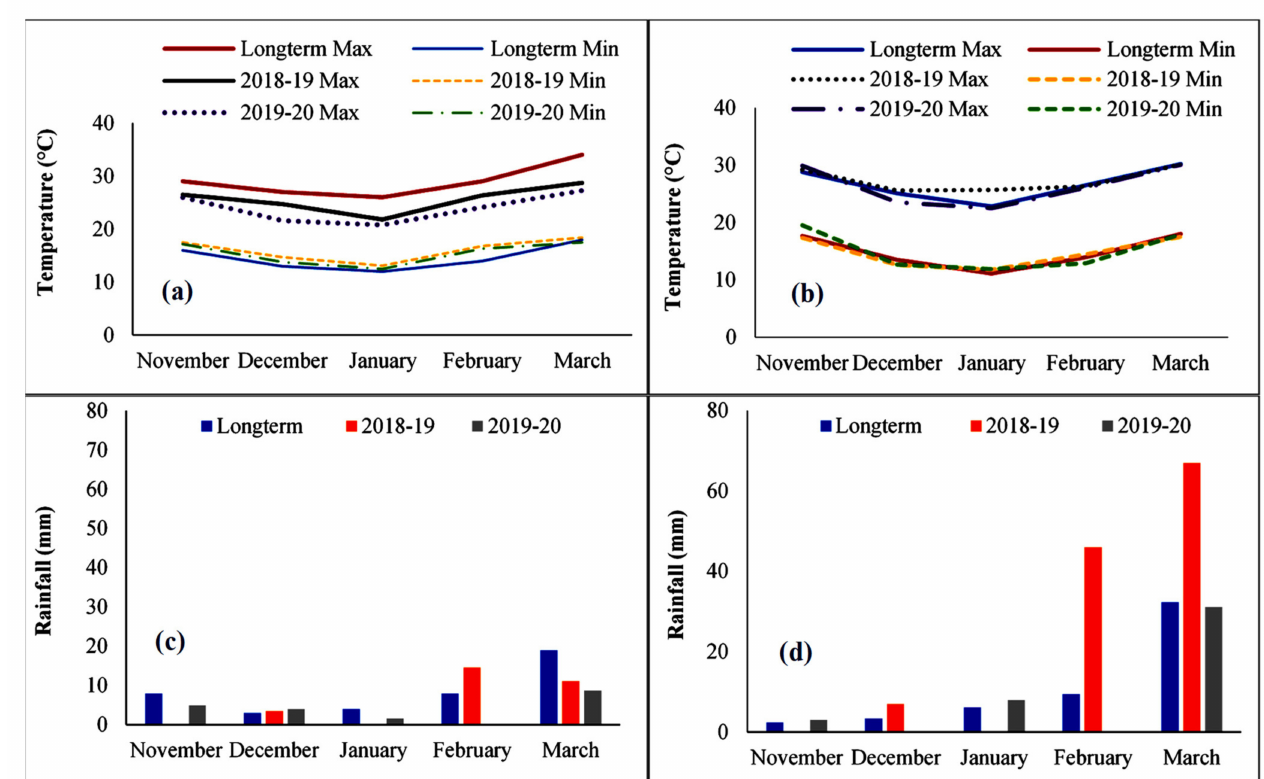
Figure 1. Monthly average maximum and minimum temperature of ( a ) Saghata, Gaibandha, and ( b ) Pirganj, Rangpur; ( c ) monthly mean rainfall (mm) of Saghata, Gaibandha, and ( d ) monthly mean rainfall (mm) of Pirganj, Rangpur, during two years compared to long-term (2000–2019) standards at Bangladesh Meteorological Department. Table 1. Initial soil condition (0–15 cm) of OFSP trial plots at Saghata of Gaibandha and Pirganj of Rangpur in Bangladesh.